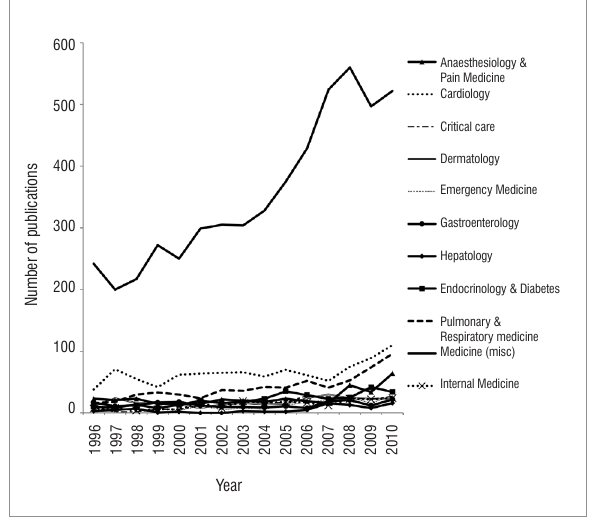
Figure 8: Number of publications from South Africa in Internal/General Medicine and its subspecialties during 1996–2010. Publication